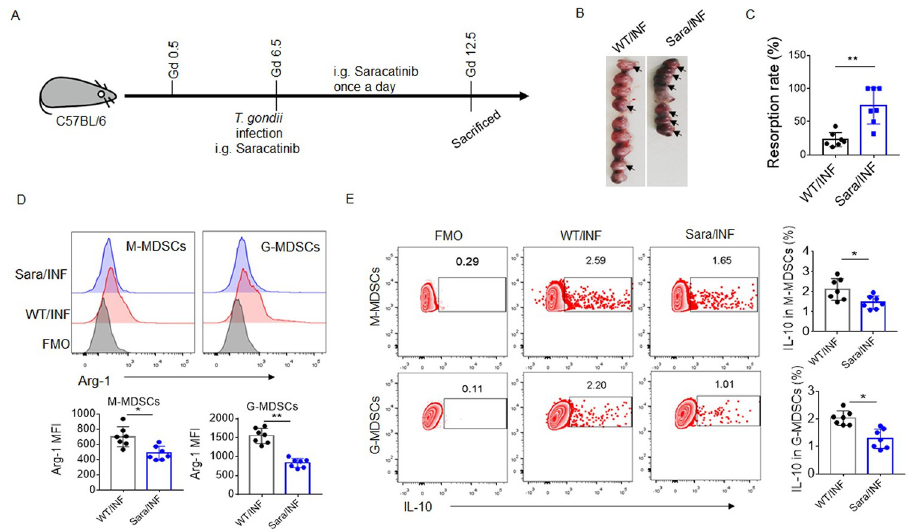
Fig 6. Saracatinib inhibits decidual MDSCs during T . gondii infection in vivo . (A) Schematic of the experiment. The detailed protocol is described in the Materials and Methods . (B–C) Representative picture and statistical analysis of uteri from the T . gondii -infected pregnant WT mice treated with or without saracatinib (Sara). Black arrows indicated resorption sites. Each symbol represents an individual animal, and the median is indicated (n = 7). (D) Representative flow cytometry results and statistical analysis of the intracellular level of p-STAT3 in decidual M-MDSCs and G-MDSCs from the infected WT mice treated with (Sara/INF) or without Sara (WT/INF) (n = 7). (E) Representative flow cytometry results and statistical analysis of the expression of Arg-1 in decidual M-MDSCs and G-MDSCs from WT/INF and Sara/INF mice (n = 7). (F) Representative flow cytometry results and statistical analysis of the intracellular level of IL-10 in decidual M-MDSCs and G-MDSCs from WT/INF and Sara/INF mice (n = 7). Cells from the WT/INF mice were used for the FMO conditions. The data are presented as the mean ± SD, * p < 0.05, ** p < 0.01, Student’s t